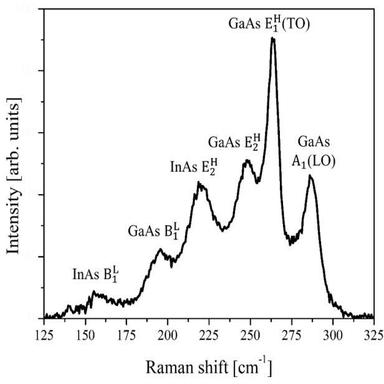
Polarization-resolved Raman spectroscopy of GaAs/InAs core/shell NWs free-standing on GaAs (001) substrate measured in Z(XY)Z configuration at room temperature. The laser has a wavalength of 532 nm and power of 30 mW.